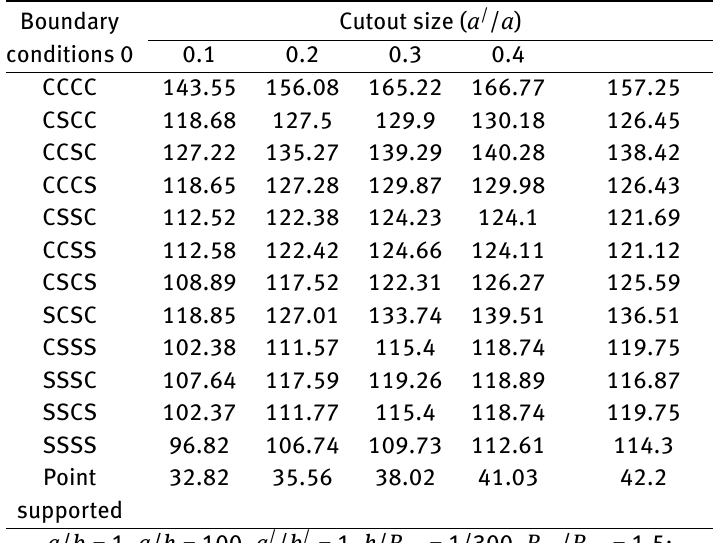
Table 4: Non-dimensional Fundamental Frequencies ( ω ) for laminated composite ( + 45/-45/ + 45/-45) stiffened elliptic parabolic shell for different sizes of the central square cutout and different boundary conditions.